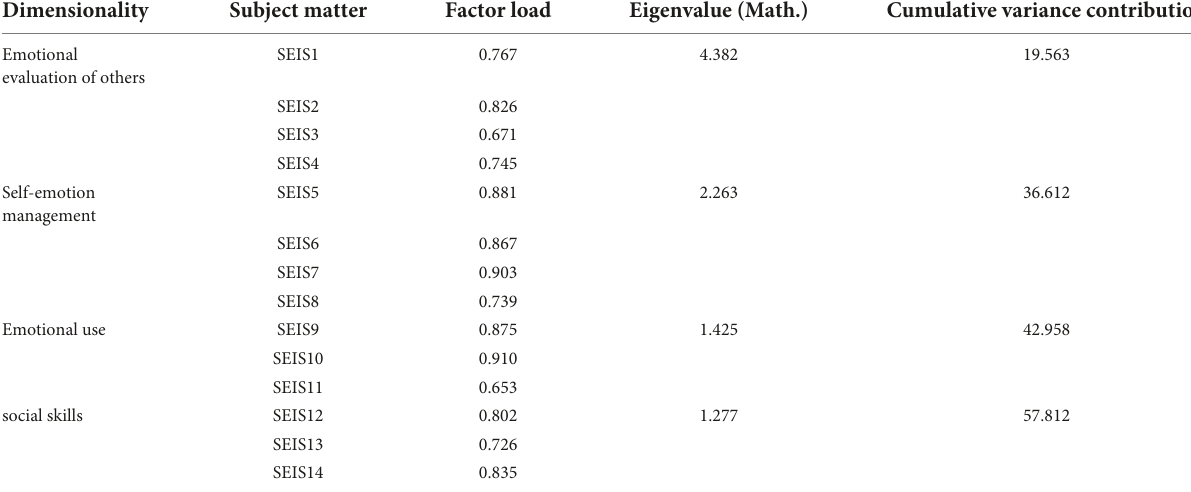
TABLE 2 Exploratory factor analysis of the Chinese version of SEIS ( n =